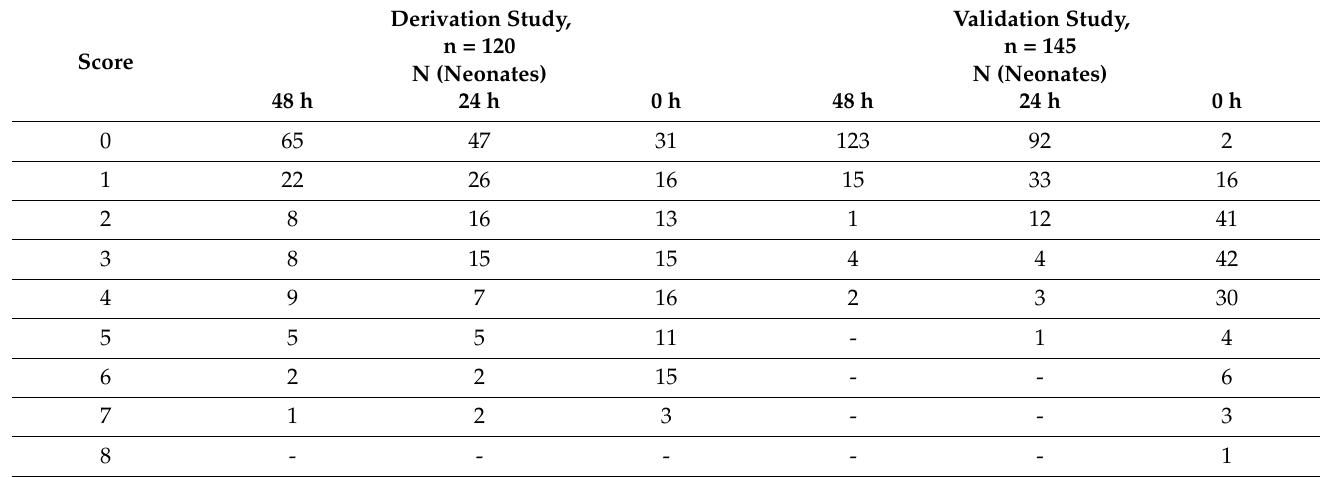
Table 5. Distribution of neonates according to the of the Sepsis Prediction Score.